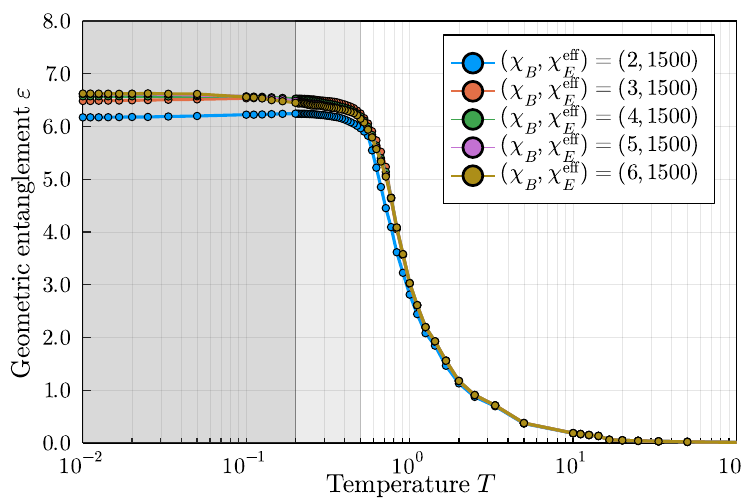
Figure 5: Geometric entanglement per site ε for the boundary MPS obtained from the CTM procedure. We observe a smooth crossover, which is incompatible with a phase transition, even of the BKT type, as explained in Ref. [ 83 ]